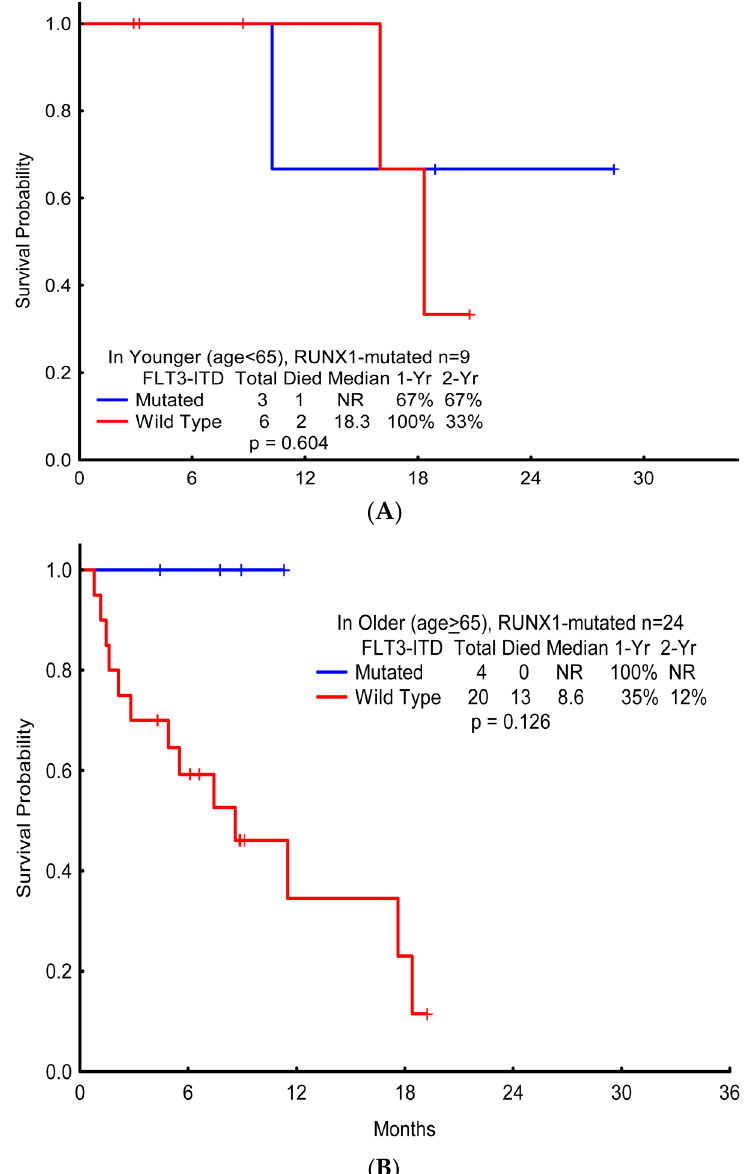
Figure A1. Survival probabilities of FLT3-ITD and RUNX1 dual-mutated patients. ( A ) Patients aged below 65 years. ( B ) Patients older than 65 years.